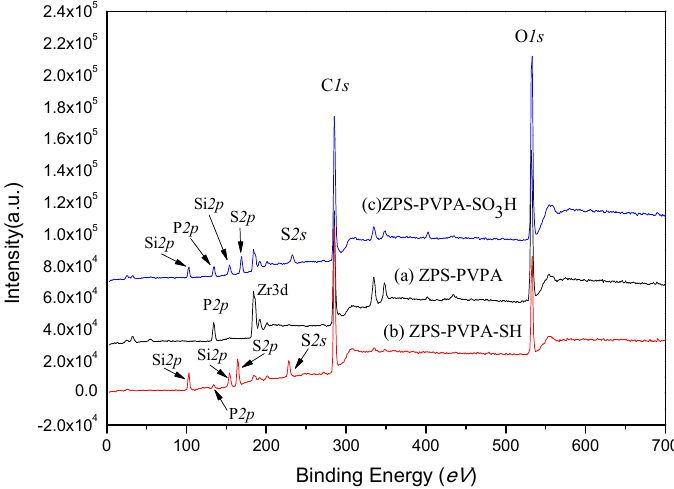
Figure 1. XPS survey scan of ( a ) ZPS–PVPA, ( b ) ZPS–PVPA–SH, and ( c ) ZPS–PVPA–SO 3 H.